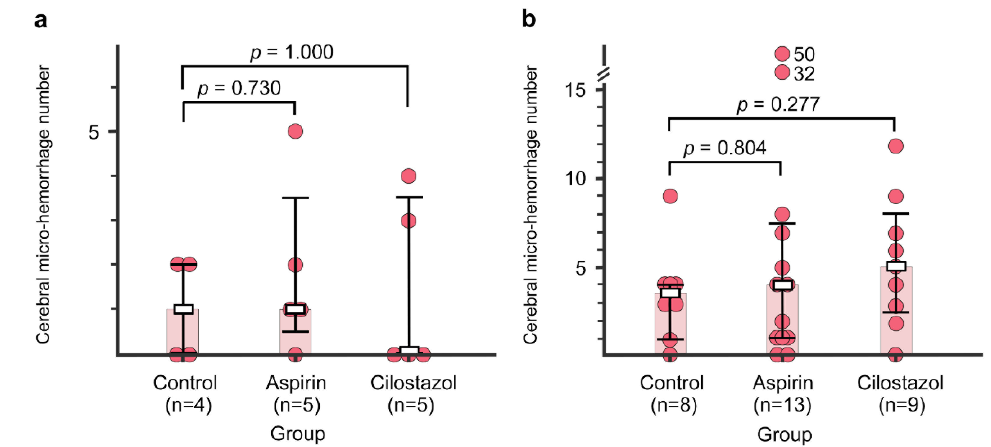
Figure 4. The number of cerebral micro-hemorrhages in the control, aspirin, and cilostazol groups evaluated at 15 months ( a ) and 21–23 months ( b ). Light-red-colored bar graphs indicate median. Boxes and bars indicate median and interquartile range, respectively. Red circles represent the number of cerebral micro-hemorrhages of each mouse. The numbers next to the red circles indicate the number of cerebral micro-hemorrhages, which are out of range of the vertical axis scale in two mice (b, Aspirin group).